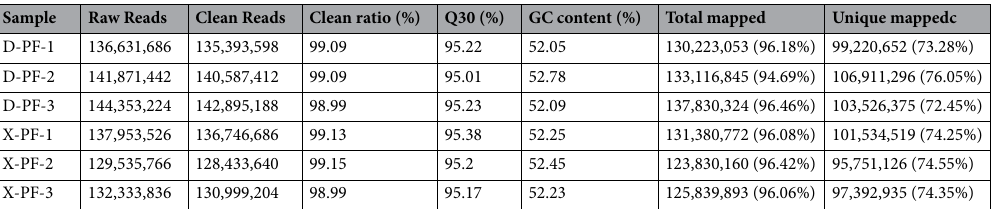
Table 1. Summary of raw reads after quality control and mapping to the reference